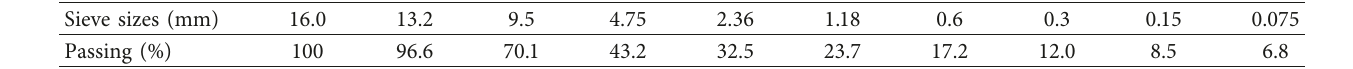
Table 1: Aggregate gradation for AC-13 mixture.